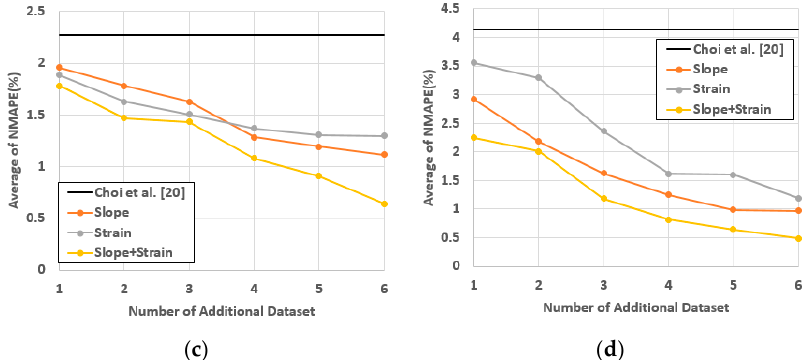
Figure 30. Mean NMAPE for displacement by additional response data: ( a ) RDS1, ( b ) RDS2, ( c ) RDS3, ( d ) RDS4.